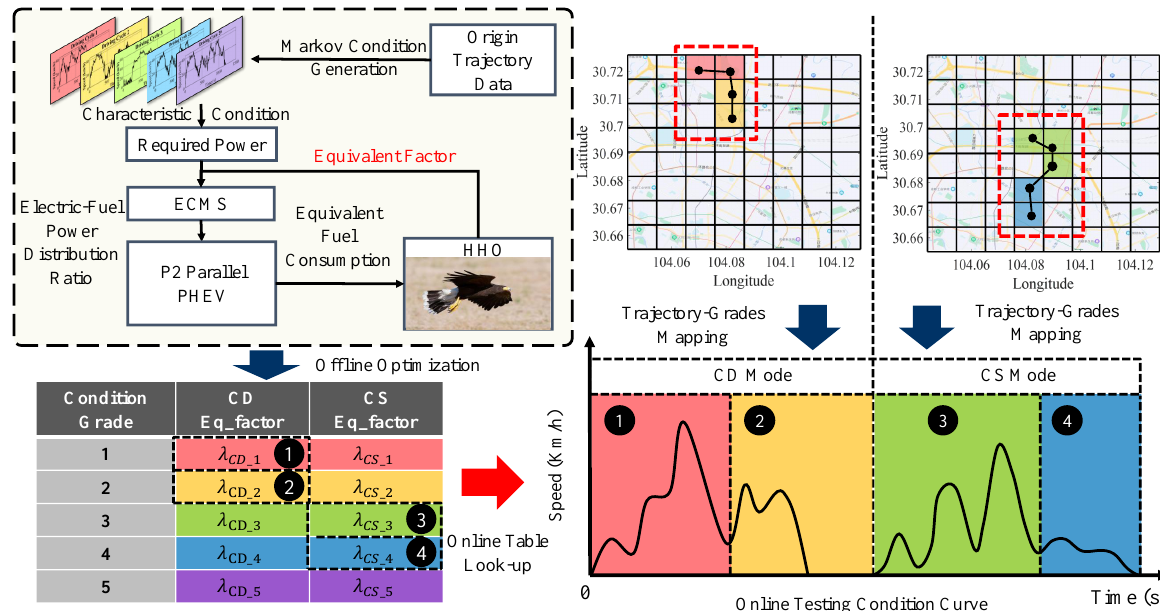
Figure 8. The operation process of EP-ECMS. Especially, The grid diagram on the upper right shows an example of the vehicle path. Among them, the red box represents the driving track of the vehicle. The vehicle is in CD mode when driving in the front section, as shown in the grid diagram on the left, while the vehicle is in CS mode in the rear section, as shown in the grid diagram on the